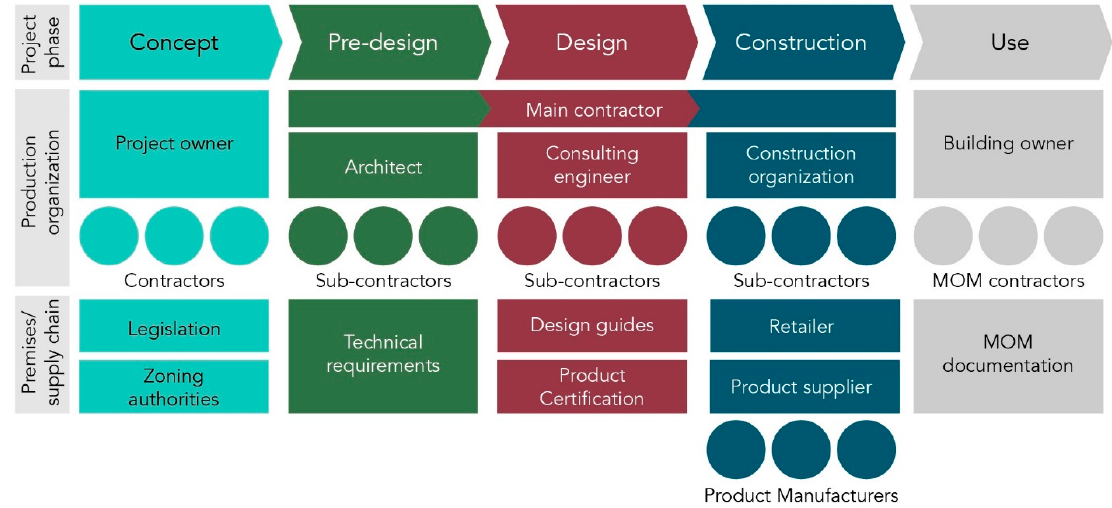
Figure 2. The phases and main involved actors in a building project, here illustrated for a design-build contract strategy. The figure is based on [59].